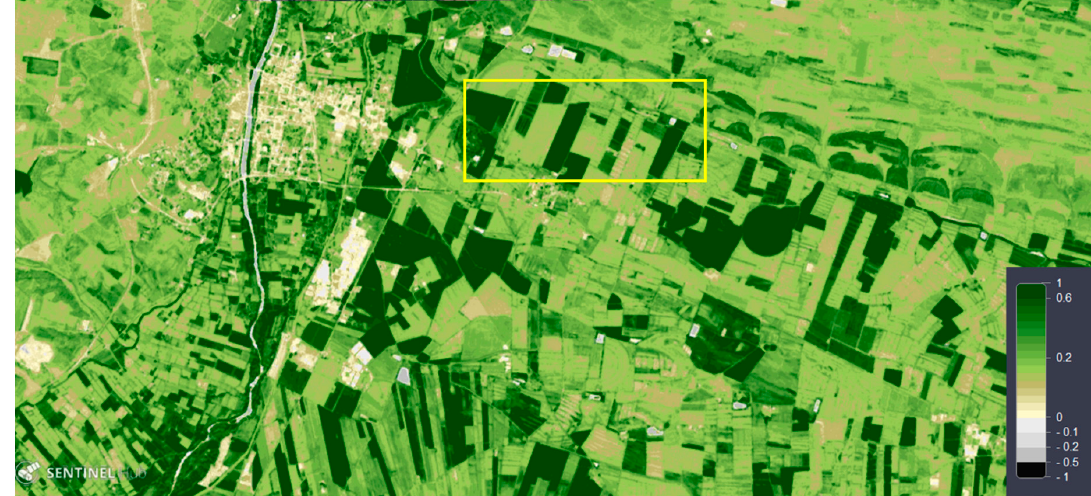
Figure 5. Normalized Difference Vegetation Index (NDVI) from Sentinel 2 L1C for October 23rd, 2018. Yellow rectangle corresponds to the second quadrant of zoom region of Figure 3. North West corner: